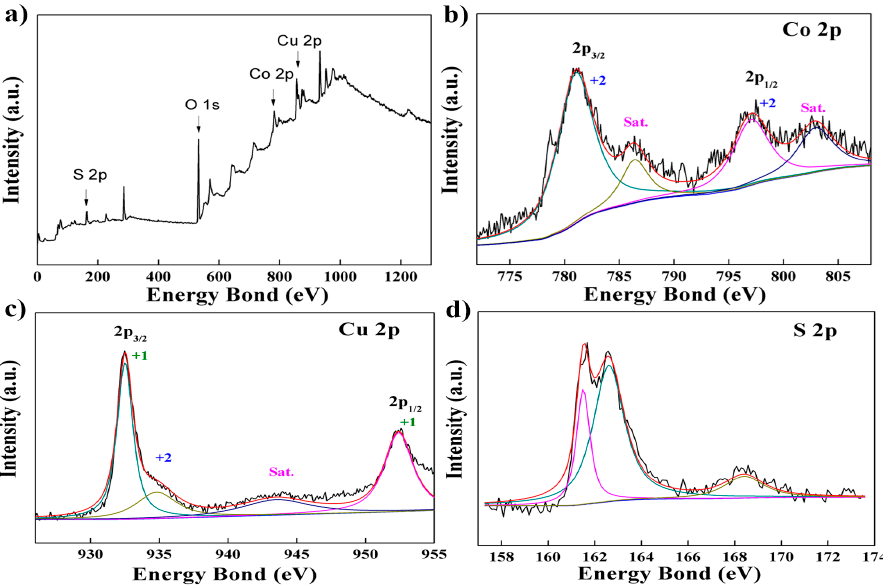
Figure 3. ( a ) The full-survey scan spectrum of O–Cu–Co sulfide; ( b ) high resolution spectra of Co 2p; ( c ) high resolution spectra of Cu 2p; ( d ) high resolution spectra of S 2p.